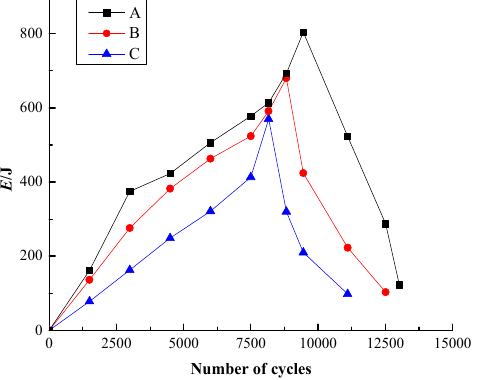
Figure 6. Internal energy storage E - number of cycles curve.